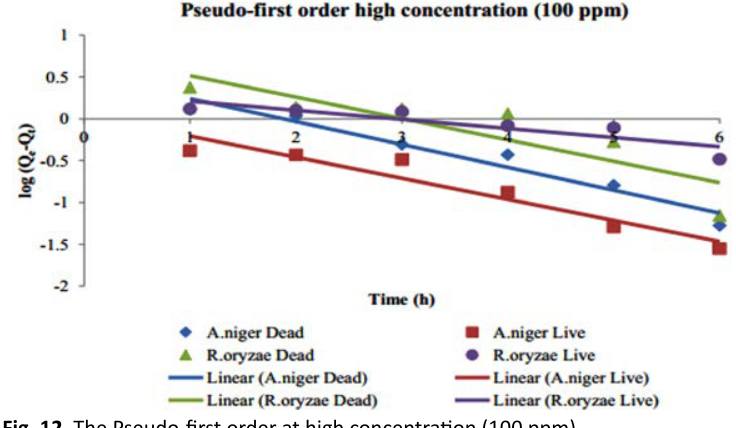
Fig. 12 . The Pseudo-first order at high concentration (100 ppm)